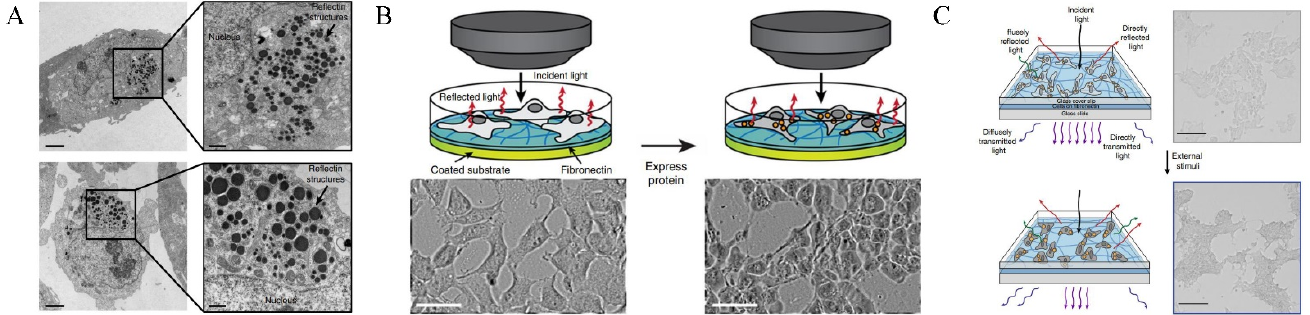
Figure 8. ( A ) Electron-dense structure of RA1 particles based on the cross-sectional view of the cells expressing RA1 observed by TEM; ( B ) Optical characteristics of the cells after expressing RA1 proteins (compared with the Petri dish substrate, the contrast increases); ( C ) changes in the transparency of cells expressing RA1 proteins before and after the treatment with sodium chloride solutions with the scale bar = 25 µm [37]. Copyright 2020, Nature Publishing Group.